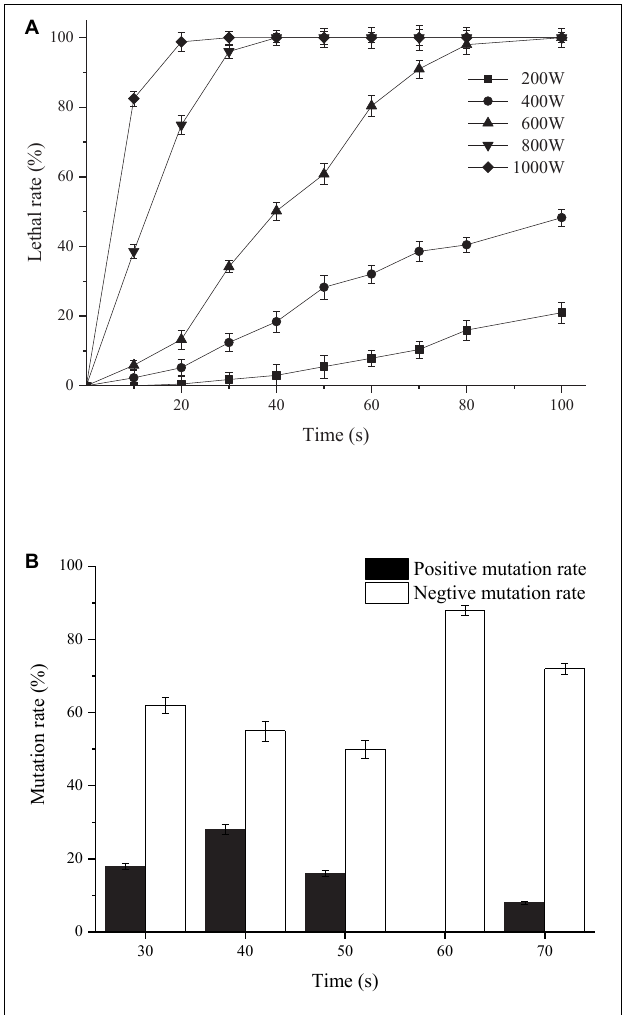
FIGURE 1 | Mutagenic effects of T. harzianum by microwave irradiation. (A) Lethal rate of T. harzianum irradiated by microwaves of different powers (200, 400, 600, 800, and 1,000 W). (B) Mutation rate of T. harzianum irradiated by microwaves of different times (30, 40, 50, 60, and 70 s) under the irradiated power of 600 W. The experiments were repeated three times.